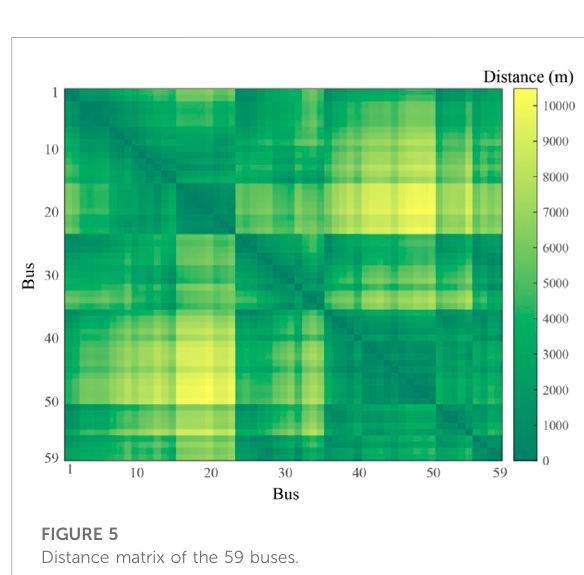
FIGURE 5 Distance matrix of the 59